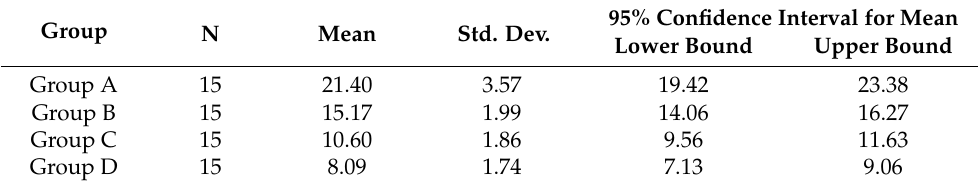
Table 2. Characteristics of mean shear bond strength acquired due to hydrofluoric acid, diamond burs, and CO 2 laser treatment, and control.